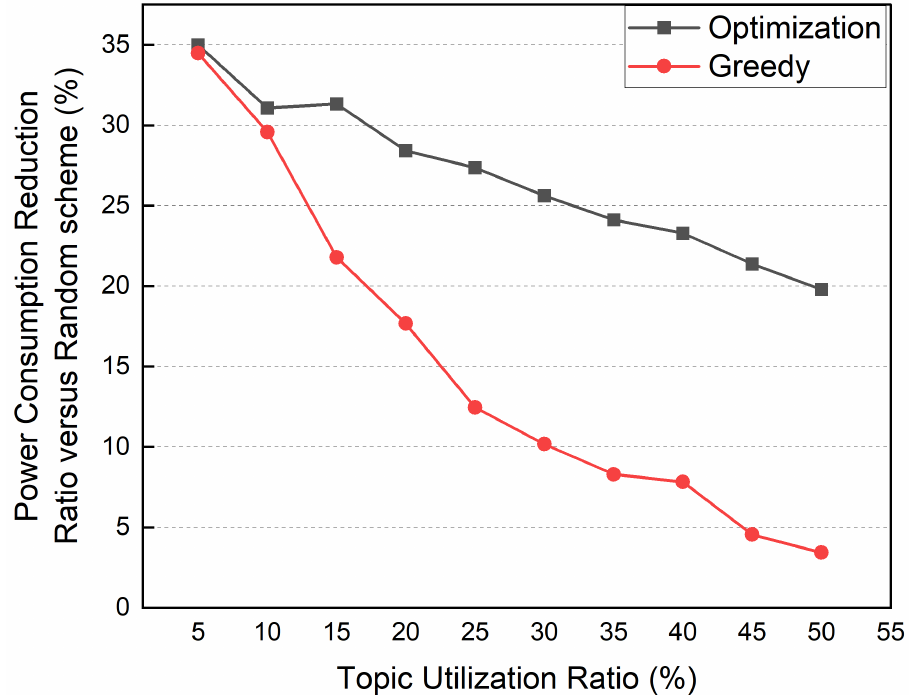
Figure 19. Power consumption comparison according to the topic utilization ratio.